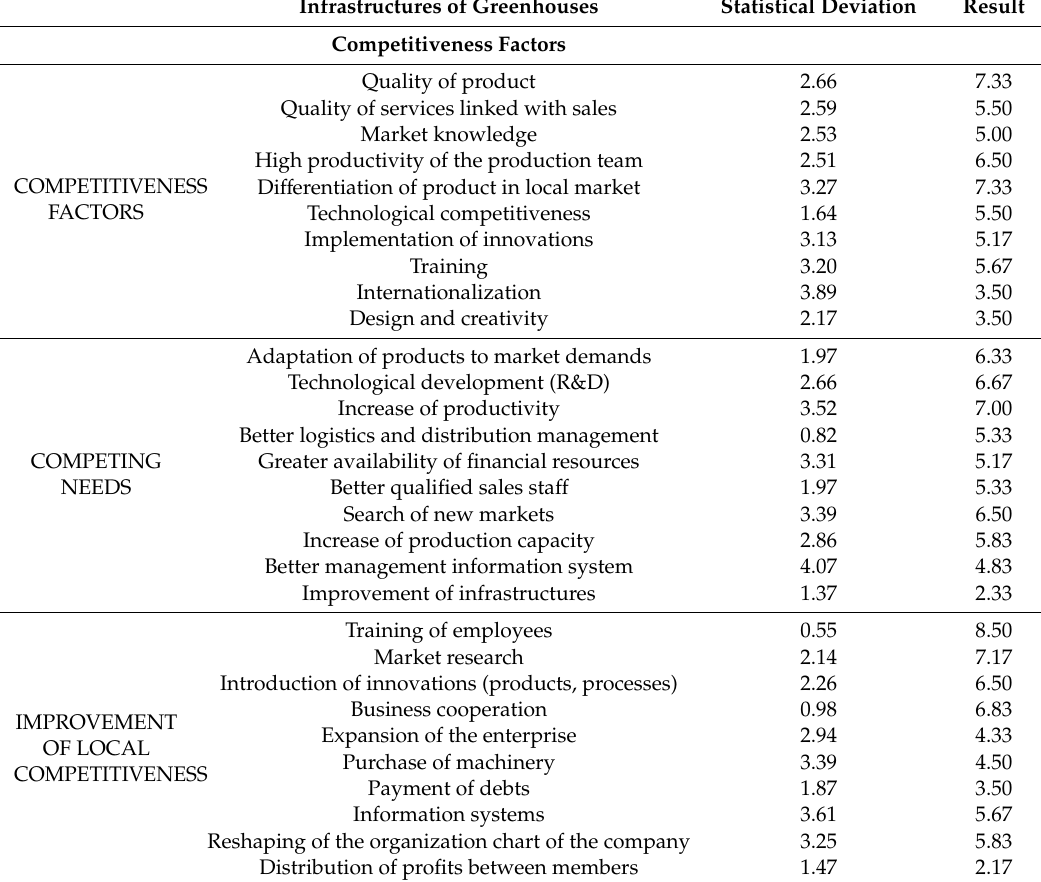
Table A1. Results and Statistical Deviation: